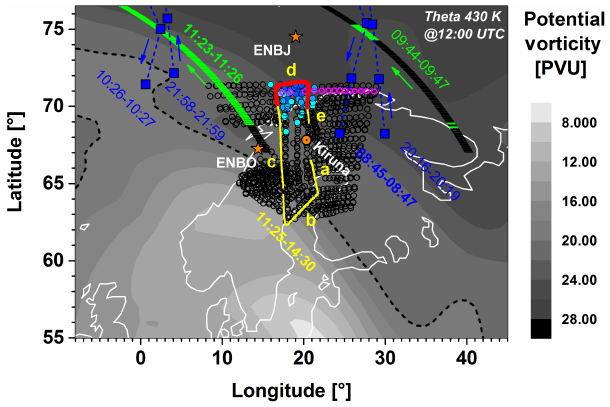
Figure 2. Vertical flight profile of the Geophysica (black line) and vertical distribution of the MIPAS-STR tangent points, color-coded with the cloud index (filled circles). Open magenta circles: MIPAS- STR limb scan associated with spectra considered in radiative trans- fer simulations. Red line: flight section of FSSP-100 and CDP PSC observations. Grey hatched areas: turns between different